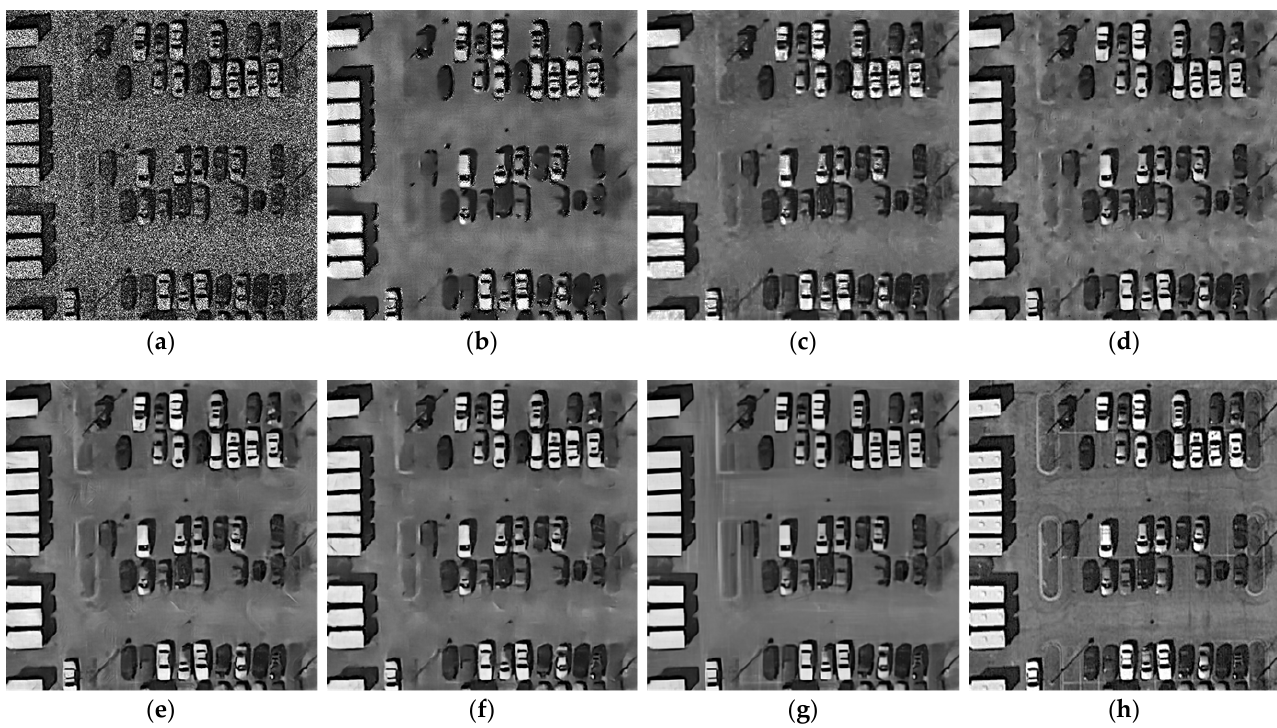
Figure 8. Despeckling results for the Parking image. ( a ) Speckled. ( b ) PPB. ( c ) SAR-BM3D. ( d ) ID-CNN. ( e ) SAR-DRN.